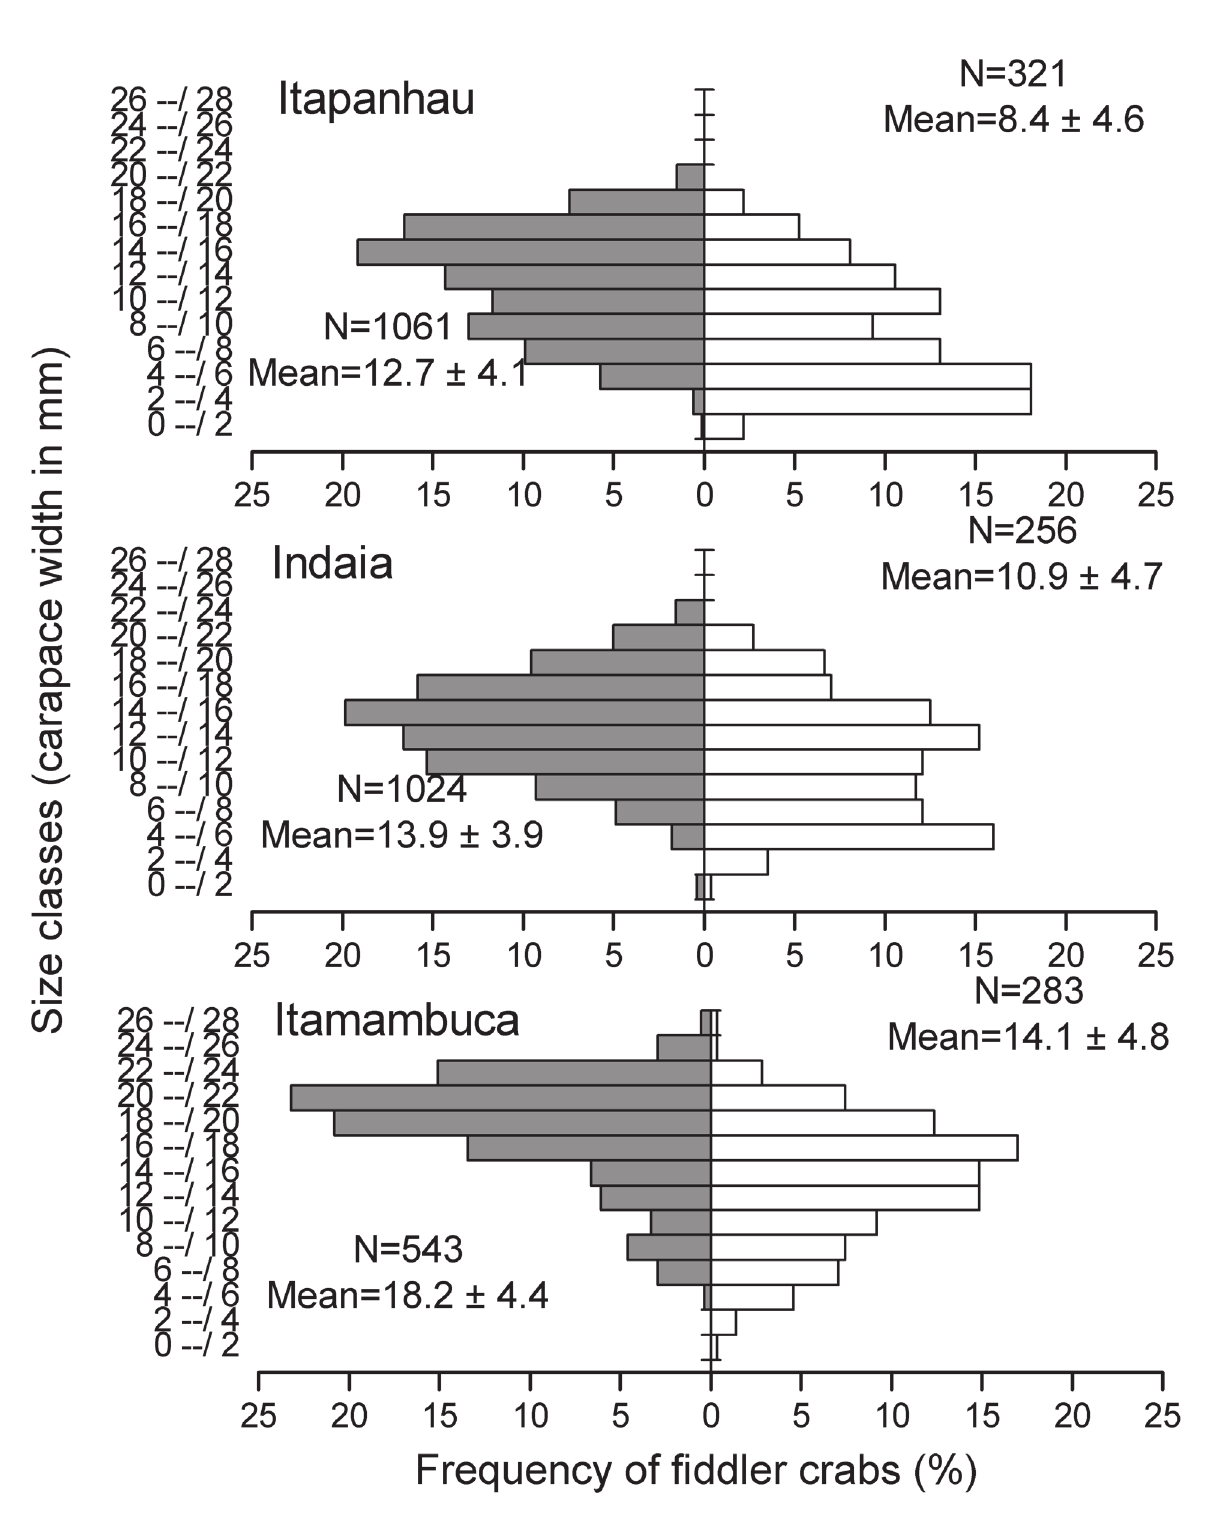
Figure 2. Minuca vocator (Herbst, 1804). Size–frequency distribution obtained by CPUE (catch-per-unit-effort – gray bars) and QT (quadrat technique – white bars) in each population. N= total number of sampled fiddler crabs. Mean and standard deviation of population (carapace width –